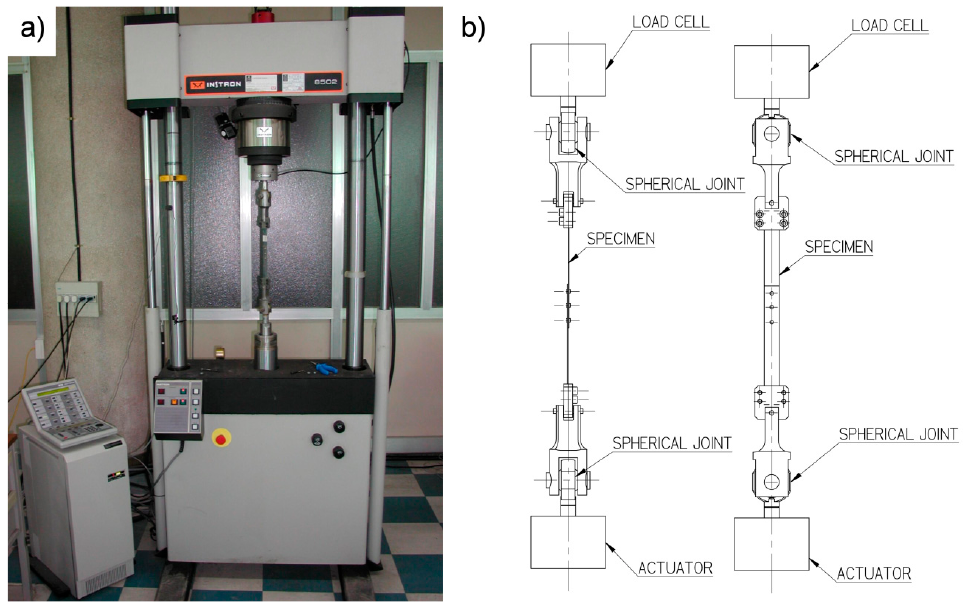
Figure 2. Fatigue test: Instron 8502 fatigue test machine ( a ); grip system ( b ).